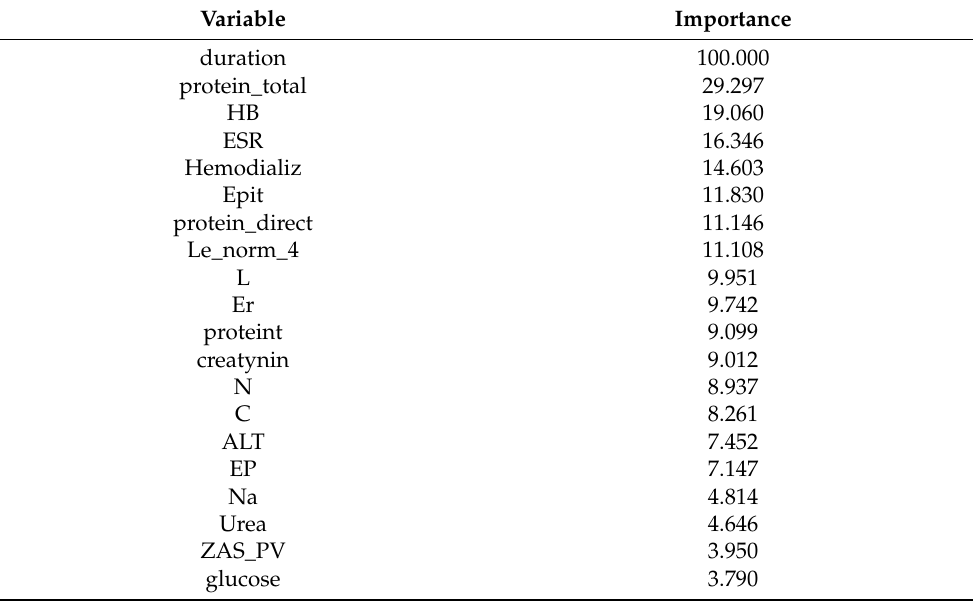
Table 3. The results of feature